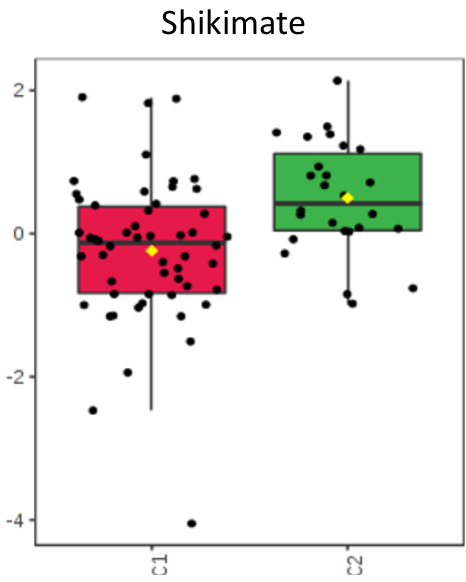
Figure 7. Concentrations compared between groups C1 and C2. Shikimate, bacterial metabolite important within the shikimate-folate pathway ( p = 0.043).